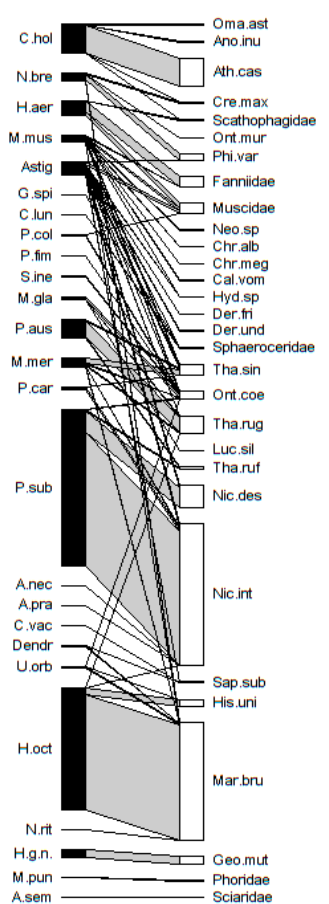
Figure 1. Bipartite network of interaction between phoretic mites’ species (left/black) and families/species of host insects (right/white). The thickness of the bond (grey) indicates the number of interactions observed. The abbreviations used are the following: A. necrophilus (A.nec), A. pratensis (A.pra), A. semiscissus (A.sem), A. inustus (Ano.inu), Astigmata (Astig), A . ( A .) castanoptera (Ath.cas), C. holsaticus (C.hol), C. lunaris (C.lun), C. vacua (C.vac), C. vomitoria (Cal.vom), Ch. albiceps (Chr.alb), Ch. megacephala (Chr.meg), C. maxil ‐ losus (Cre.max), Dendrolaelaps sp. (Dendr), D. frischii (Der.fri), D. undulatus (Der.und), G.